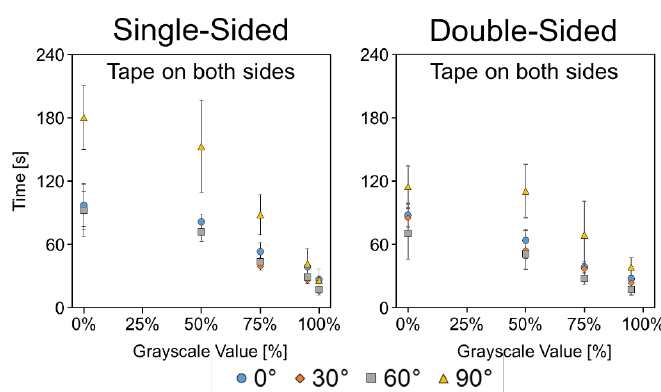
Figure 8. Angled wicking data for single- and double-sided etched channels with tape on both sides. Data presented as mean ± SD. n = 5. Data presented as mean ± SD. n =